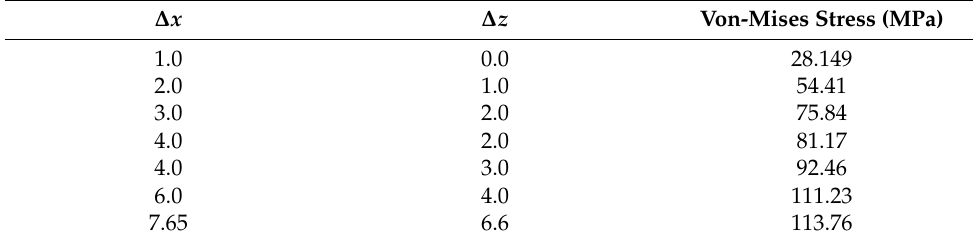
Table 4. Estimated stress of the H-joint with respect to the relative